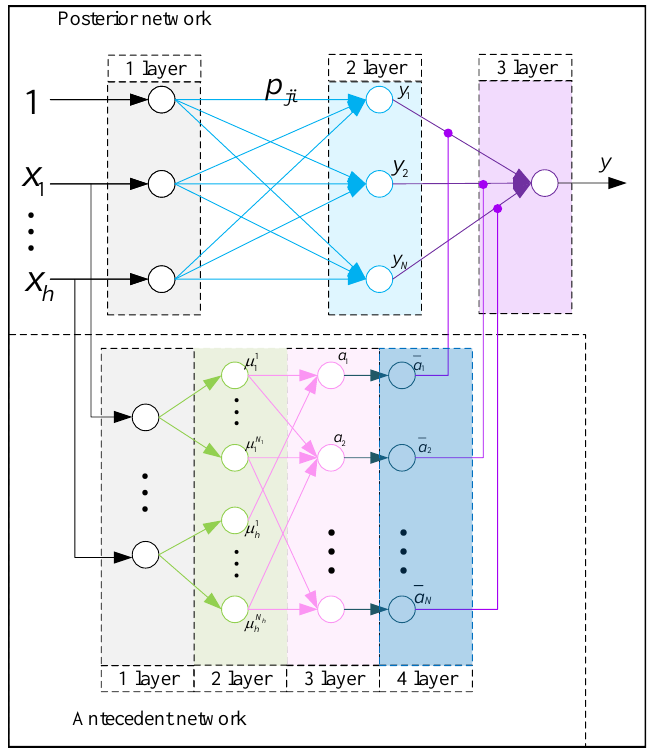
Figure 2. The T-S FNN structure for predicting the crop growth